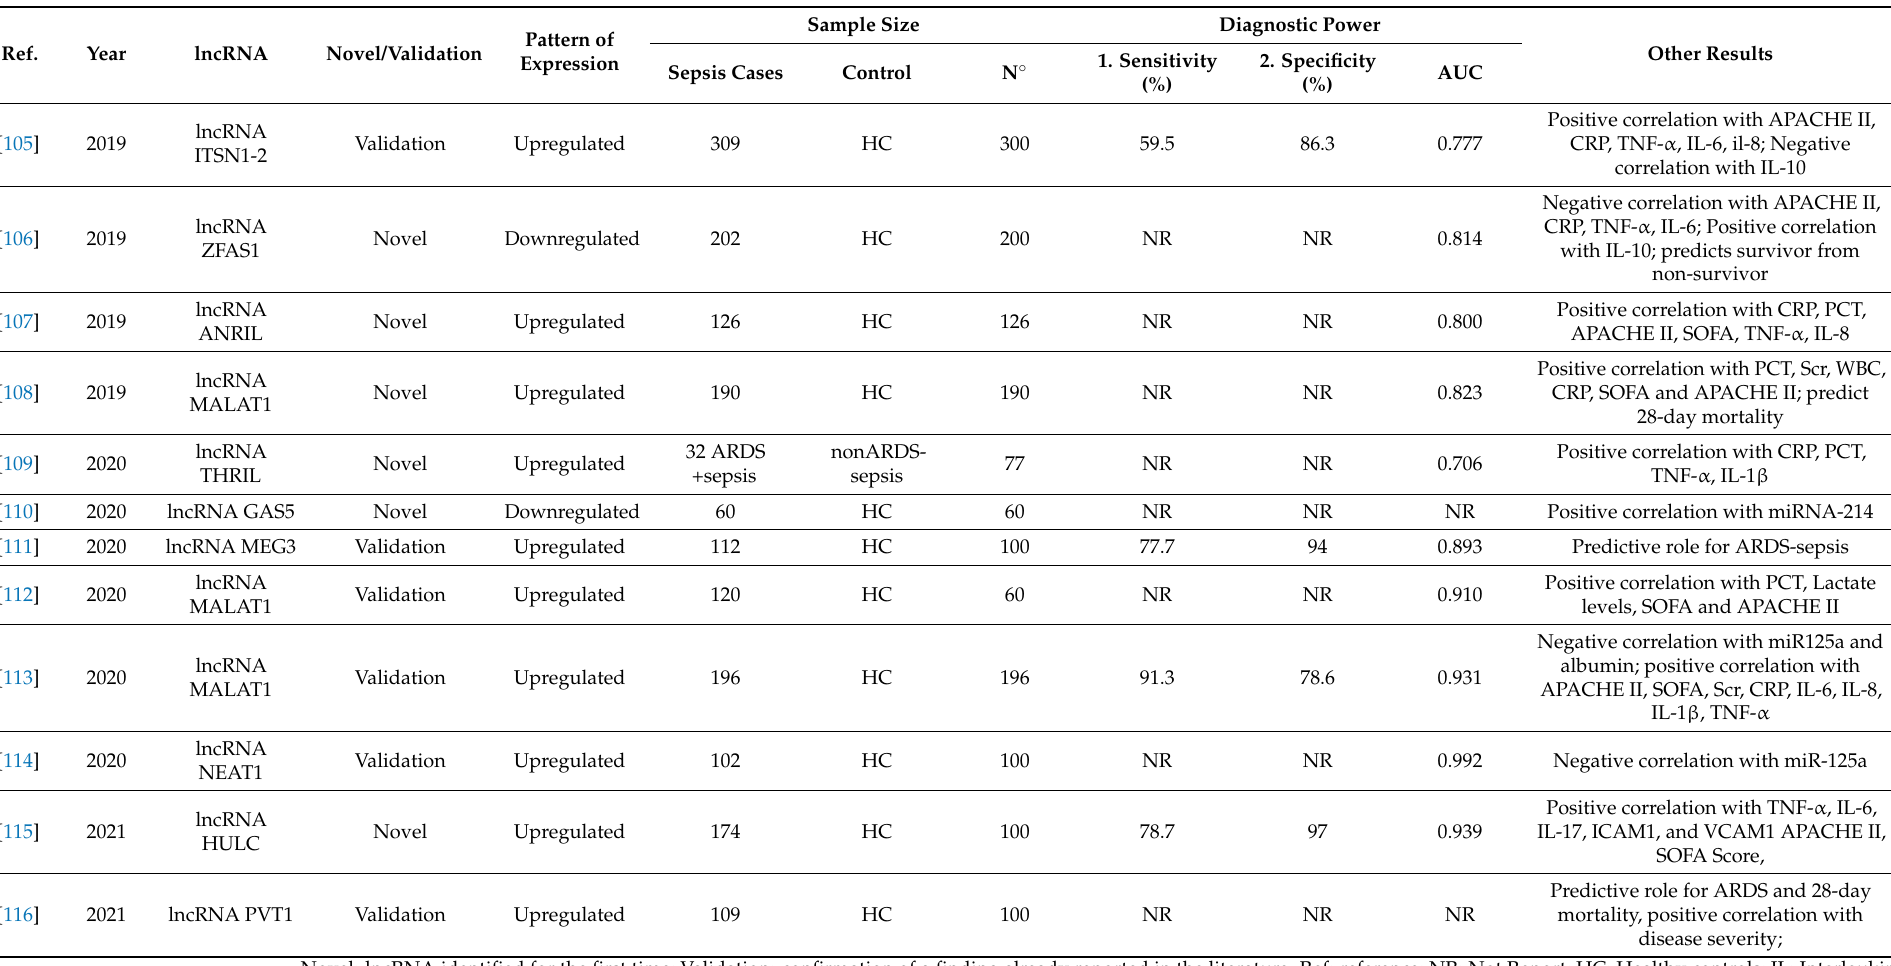
Table 1. Main findings of the study regarding lncRNAs addressing the issue of their reliability as biomarker and prognostic tool in clinical settings of sepsis in humans.